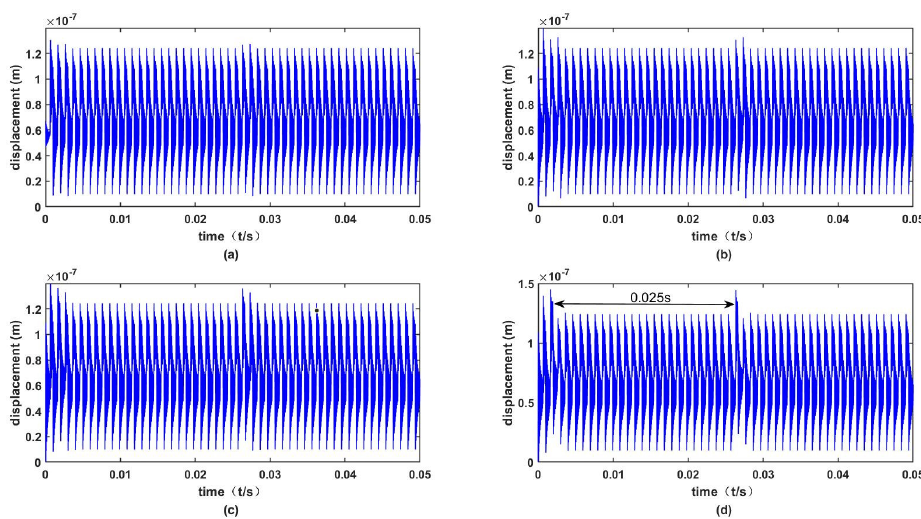
Figure 11. Vibration response with different crack depths. ( a ) Crack depth 0.5 mm. ( b ) Crack depth 1.0 mm. ( c ) Crack depth 1.5 mm. ( d ) Crack depth 2.0 mm.